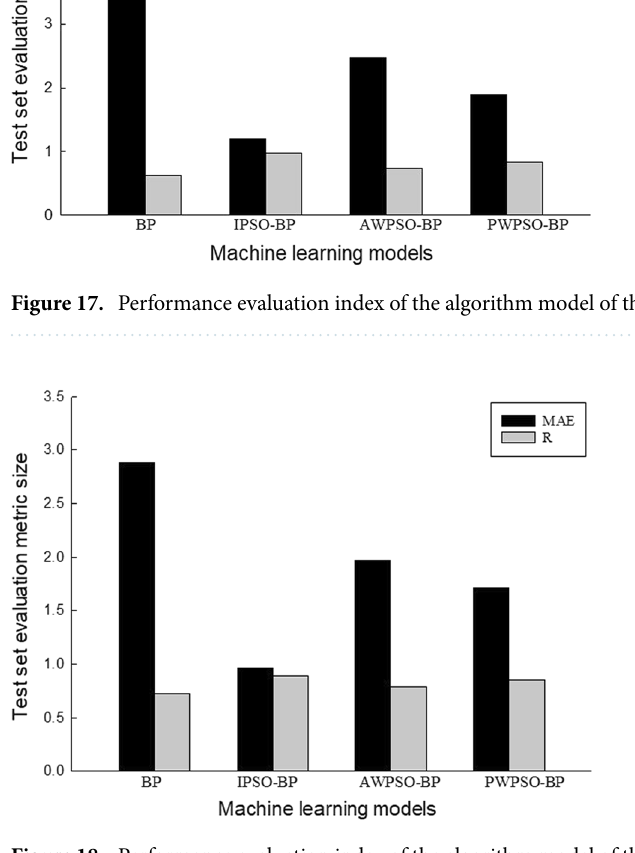
Figure 18. Performance evaluation index of the algorithm model of the left test